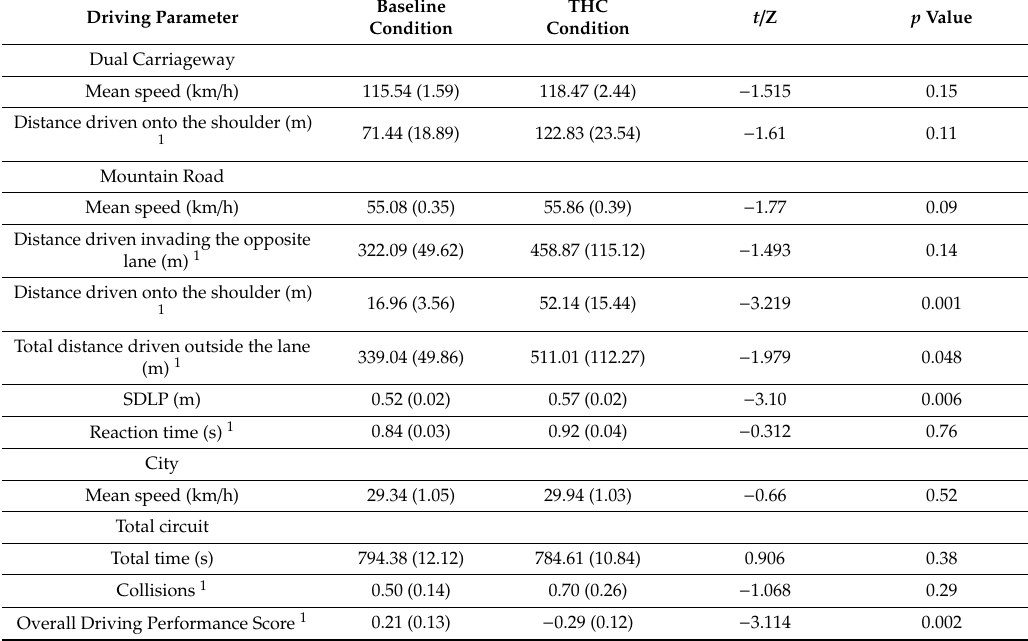
Table 3. Comparison of driving performance variables in the baseline session and after smoking